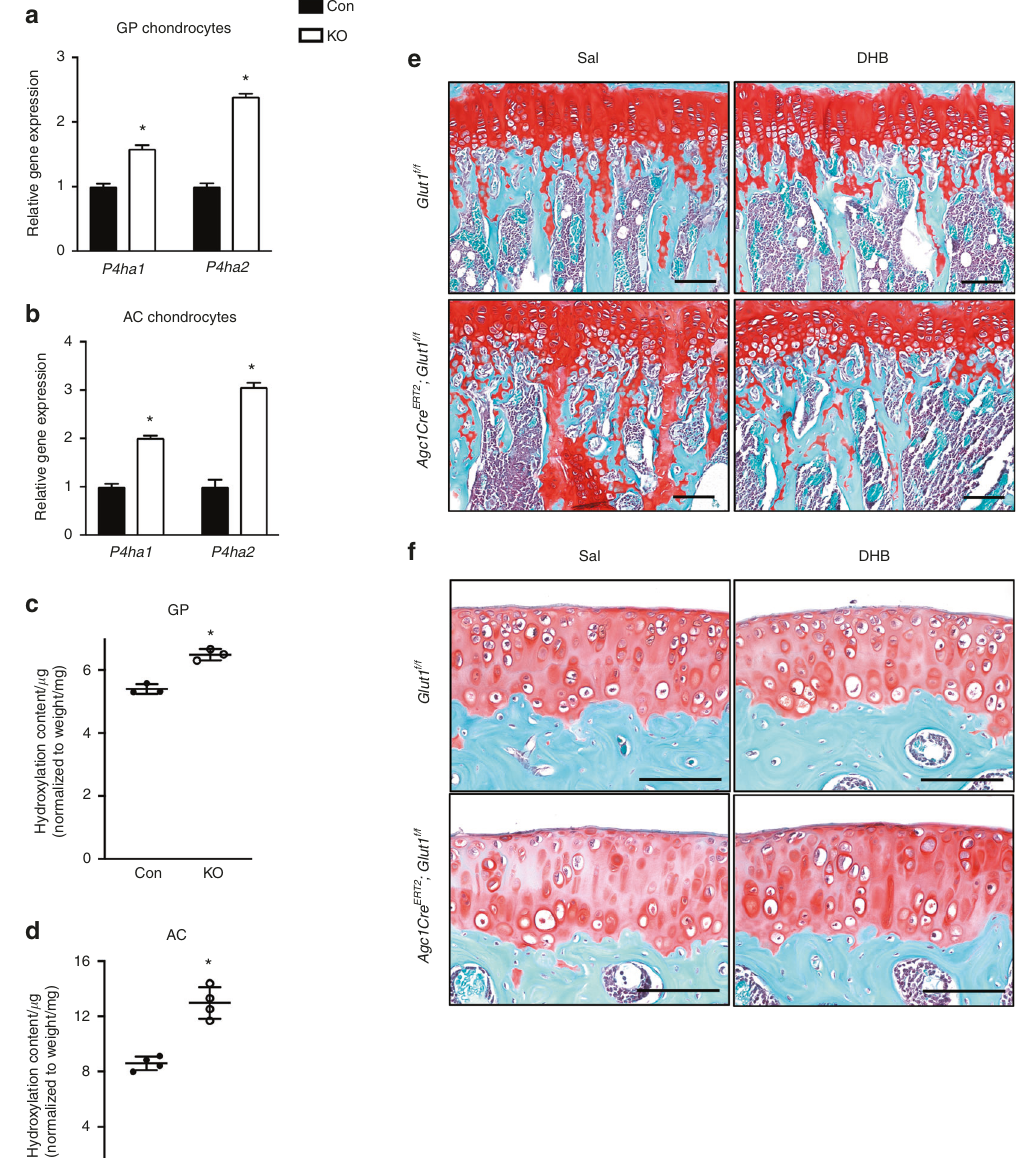
Fig. 7 Inhibition of P4h in vivo normalizes increased the amount of cartilage remnants in the metaphyseal region in Glut1 LOF mice. a – b RT- qPCR analyses for P4ha1 and P4ha2 in control and Glut1 KO primary GP chondrocytes. The data are the mean ± SD. N = 3. * P < 0.05 relative to the controls. c – d Hydroxyproline levels in control and Glut1 LOF neonatal growth plates and 3-week-old articular cartilage from femoral heads. All data are normalized to the tissue weight. The data are the mean ± SD. N = 3 or 4 biologically independent samples. * P < 0.05 compared to the controls. e – f Safranin O/Fast Green staining of tibia and knee sections of 3-month-old control and Glut1 LOF mice following DHB or saline treatment for 2 months. N = 5. Scale bar, 100 μ LOF, our study provides the fi rst evidence of metabolic plasticity DISCUSSION exhibited by both GP and AC chondrocytes that allows these cells The present work provides genetic and metabolic evidence that to switch to glutamine oxidation to support energy production Glut1-mediated glucose metabolism is critical for postnatal GP when glucose metabolism is compromised. Collectively, our work growth and maintenance of AC homeostasis. Deletion of Glut1 in highlights the pivotal and distinct roles of Glut1-mediated glucose chondrocytes during early postnatal development disrupts GP function and results in reduced longitudinal bone growth by interfering with chondrocyte proliferation and matrix synthesis and processing. Inhibiting Glut1 in AC, on the other hand, results in diminished cellularity and in imbalanced tissue anabolism and catabolism, with ultimate progression to cartilage fi brosis. More- over, Glut1 LOF AC has increased susceptibility to injury-induced OA. Despite the disparate cellular phenotypes caused by Glut1